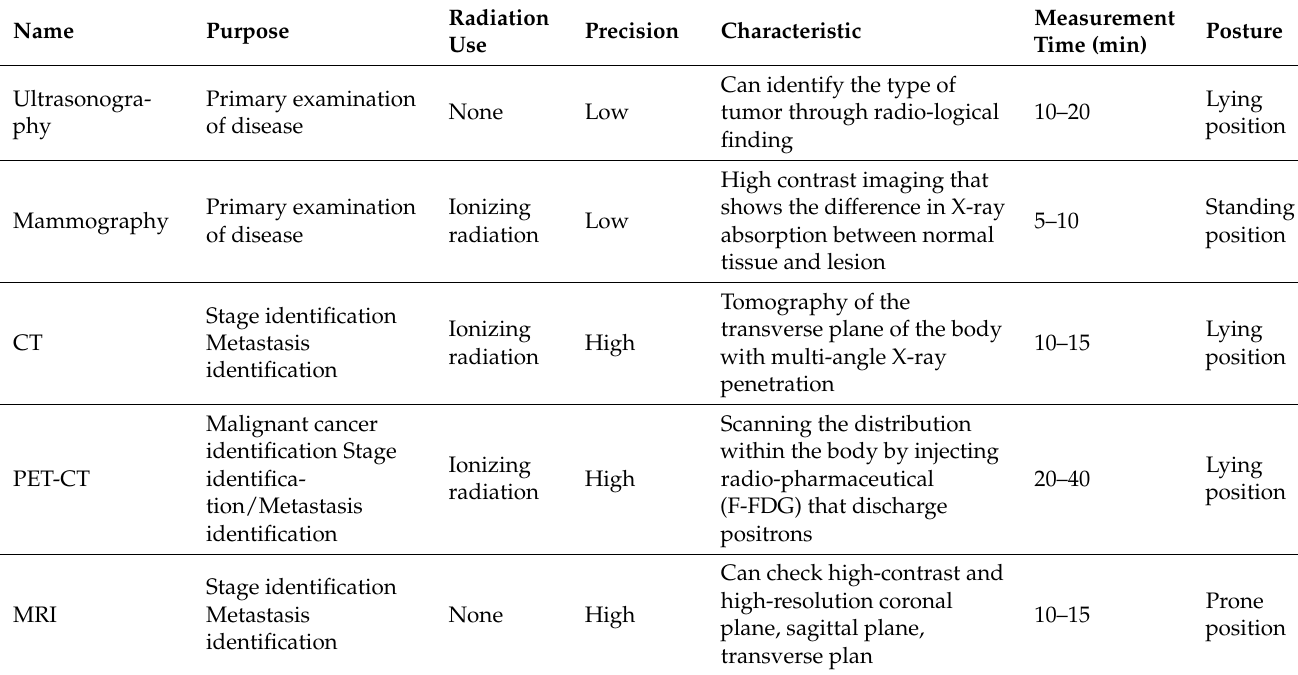
Table 1. Methods and characteristics of imaging for medical